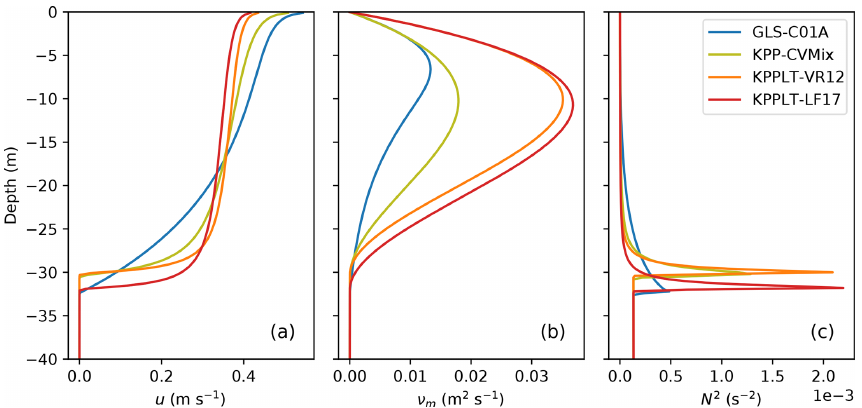
Figure 2. Vertical profiles of (a) down-wind velocity u , (b) turbulent viscosity ν m , and (c) squared buoyancy frequency N 2 at the end of the 30h simulations.